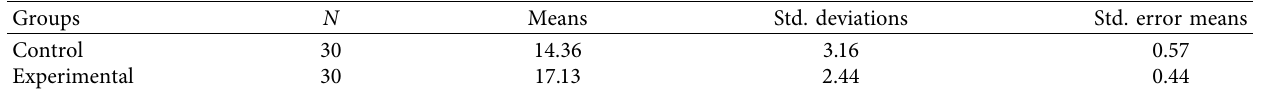
Table 8: Descriptive statistics of the experimental and control groups in the vocabulary posttests.